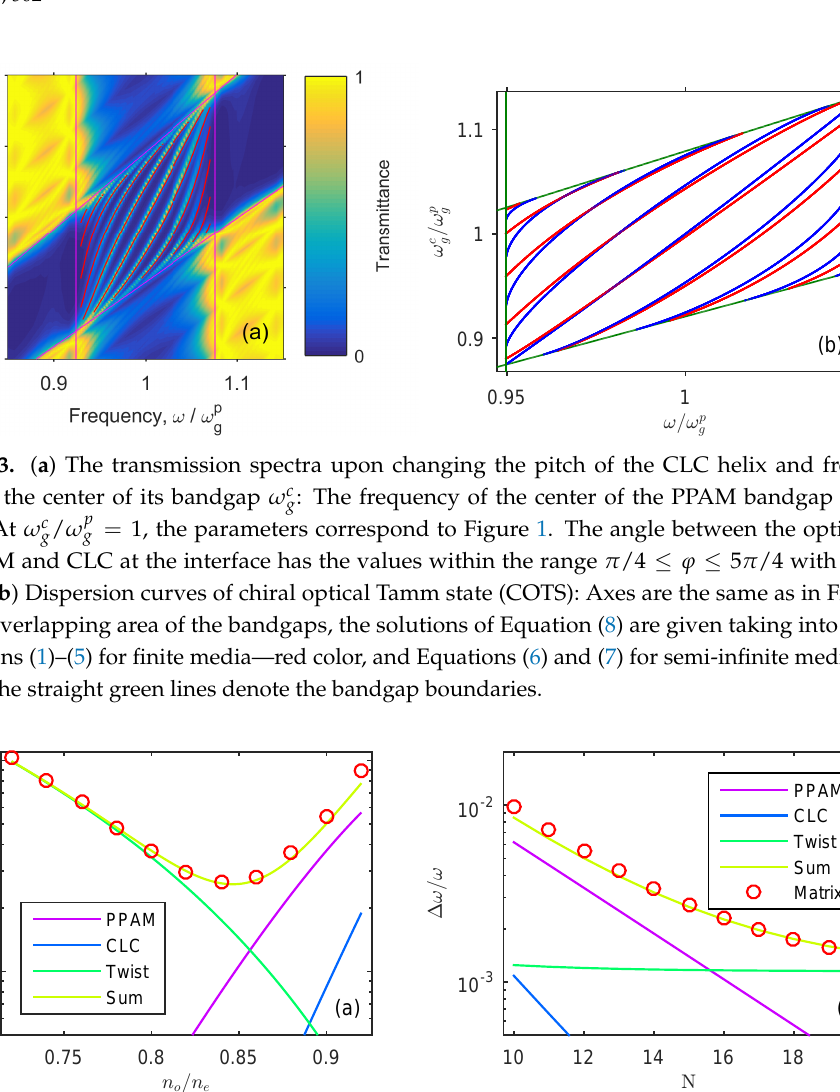
Figure 4. The normalized spectral line-width ∆ ω / ω of COTS upon changing ( a ) the contrast n o / n e and ( b ) the number of periods N for both PPAM and CLC: The coupled-mode theory is confirmed by the Berreman transfer matrix method. In Figure 4a, the number of periods is N = N p = N c = 15, and in Figure 4b, the contrast is n p o / n p e = n c o / n c e = 0.86 ≈ 1.45/1.7. In both cases, the centers of the PPAM and CLC bandgaps coincide: ω p g = ω c g